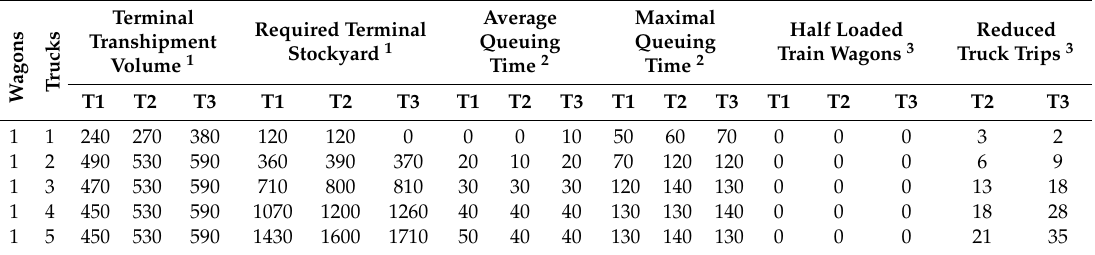
Table A4. Terminal transport template for two train pick-ups, short delivery time, and all tonnages (P2D1 T1 / 2 /